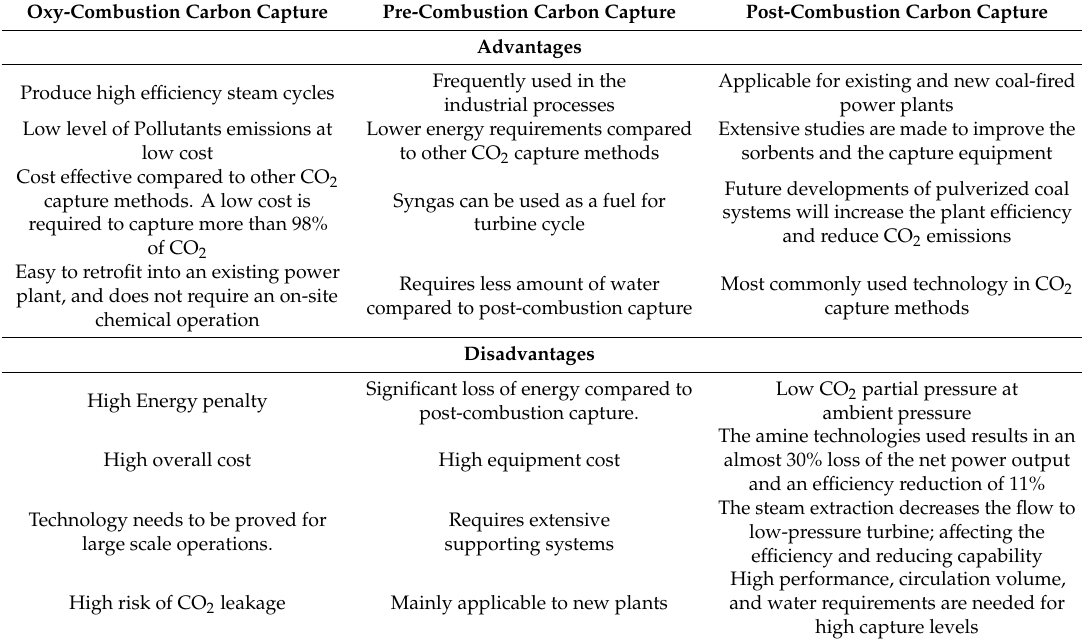
Table 5. Advantages and disadvantages of oxy-fuel combustion capture, pre-combustion capture, and post-combustion capture.